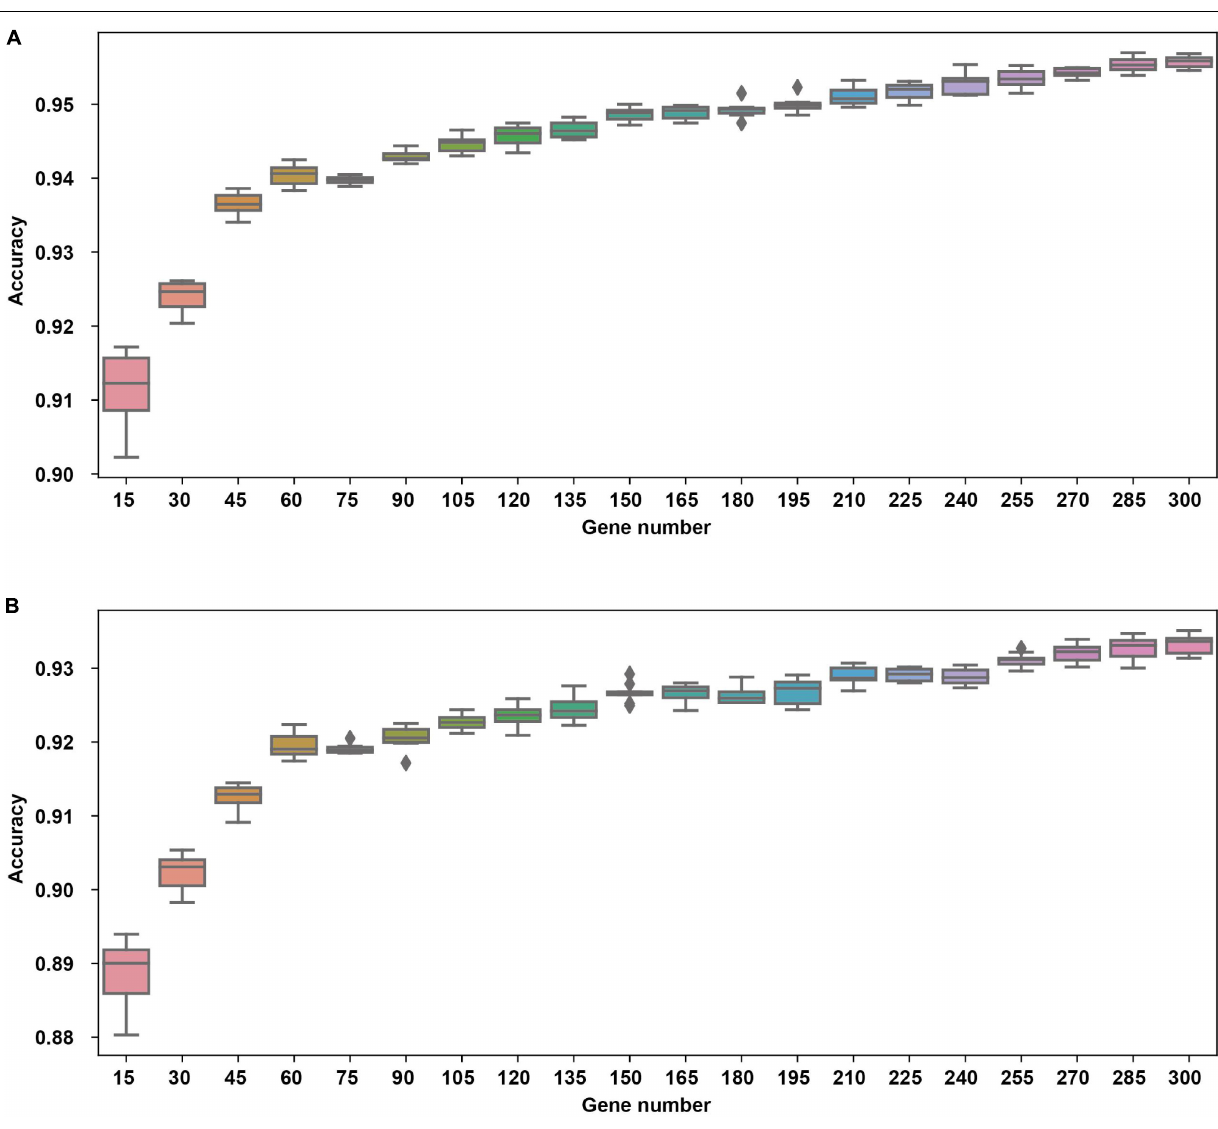
Frontiers in Bioengineering and Biotechnology |